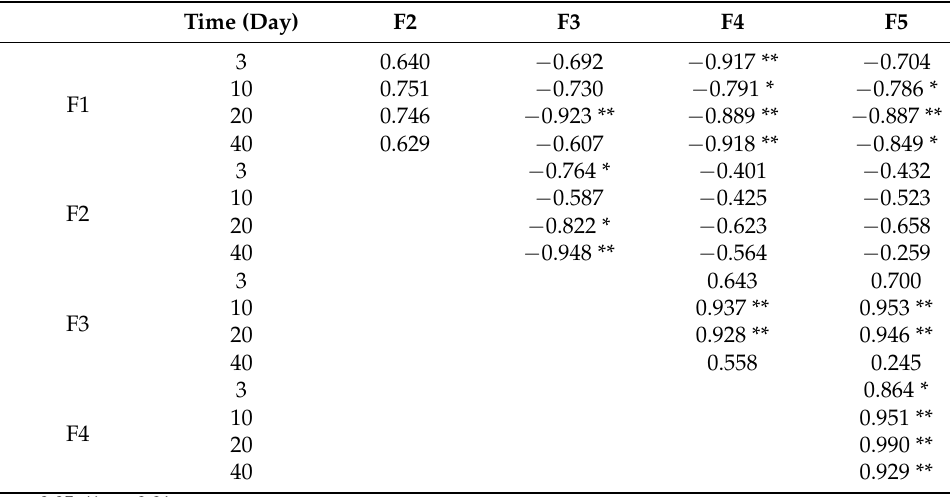
Table 4. Pearson correlation coefficients between different fractions.